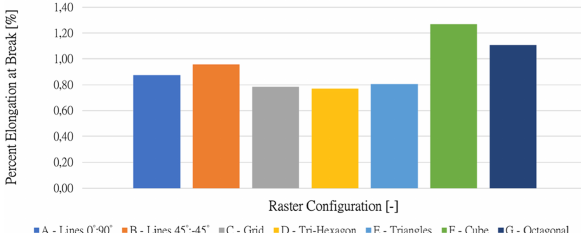
Figure 6: Comparison of specimen classes with Percent Elongation at Break [%]